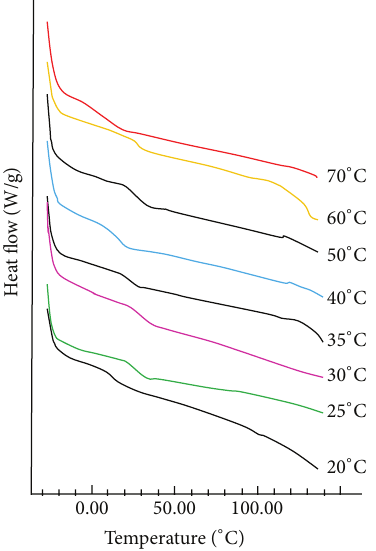
Figure 5: Typical DSC thermograms of the prepared PCHO obtained at a heating rate of 20 ∘ C/min. Polymerization catalyzed by 0.2 g of H 3 PW 12 O 40 during 3 hours in CH 2 Cl 2